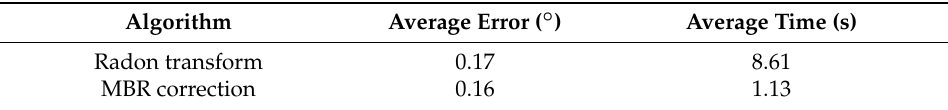
Table 1. Data statistics of nine pictures by 6 × 6.